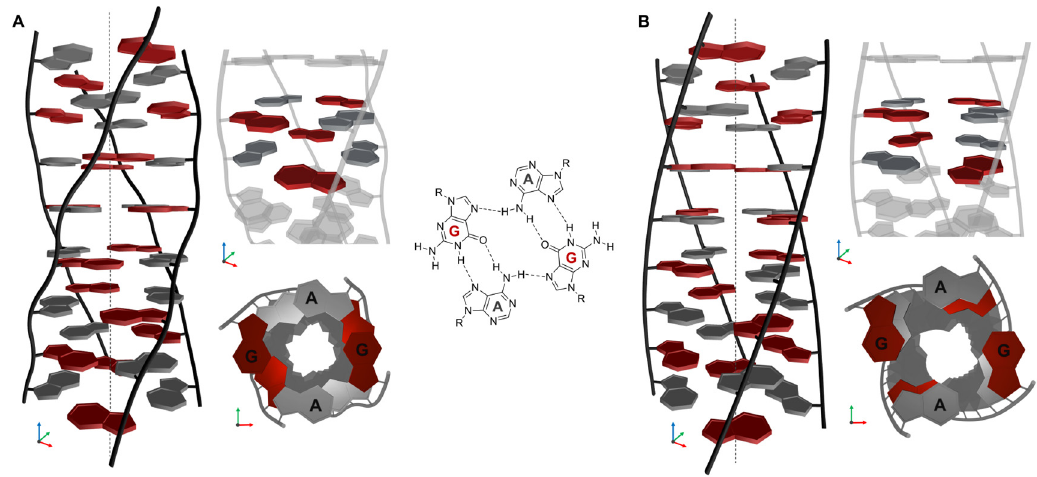
Figure 9. ( A ) Proposed noncanonical motif based on analogies with the noncanonical tetrahedral VK structure, in which the guanines in one AGAG-quartet are oriented in syn- and in anti-conformation in the adjacent quartet. The core of the structure is formed by unusual AGAG-quartets stacked on top of each other. A schematic representation of the AGAG-quartet is shown in the middle. ( B ) Structural model in which all guanines are oriented in the syn-conformation. The schematic representation of the structures was created in the Blender 3.5 freeware modeling tool.